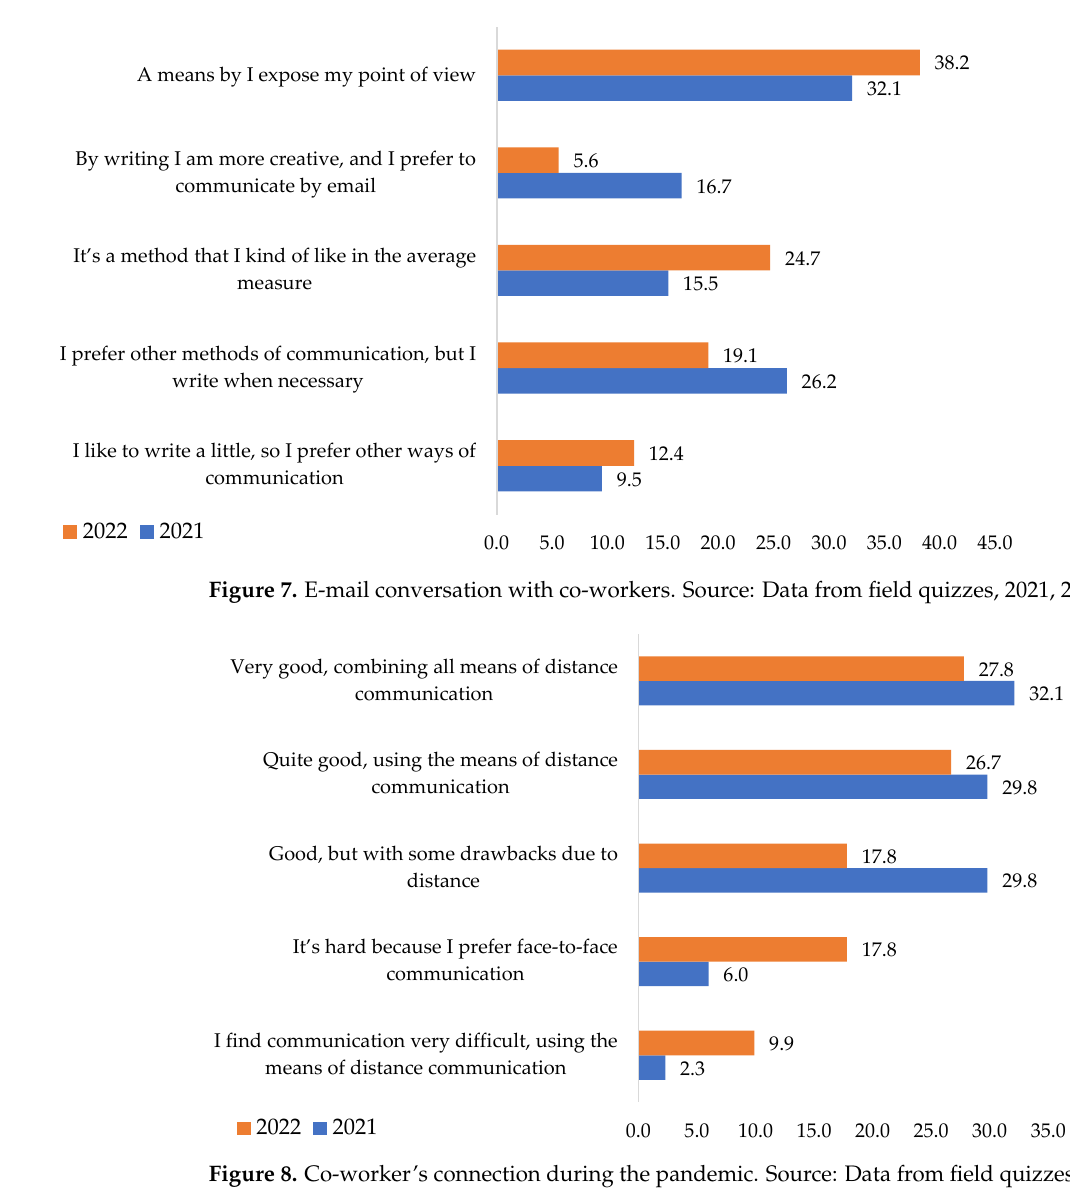
Figure 8. Co-worker’s connection during the pandemic. Source: Data from field quizzes, 2021, 2022. Conversation with co-workers remains an important issue for respondents. The re- search results confirmed the H4 hypothesis that during the COVID-19 period, direct com- munication with co-workers was different from that under normal conditions. In this case, the two variables were associated. It can be said that direct contact in labor relations is better without social distance.